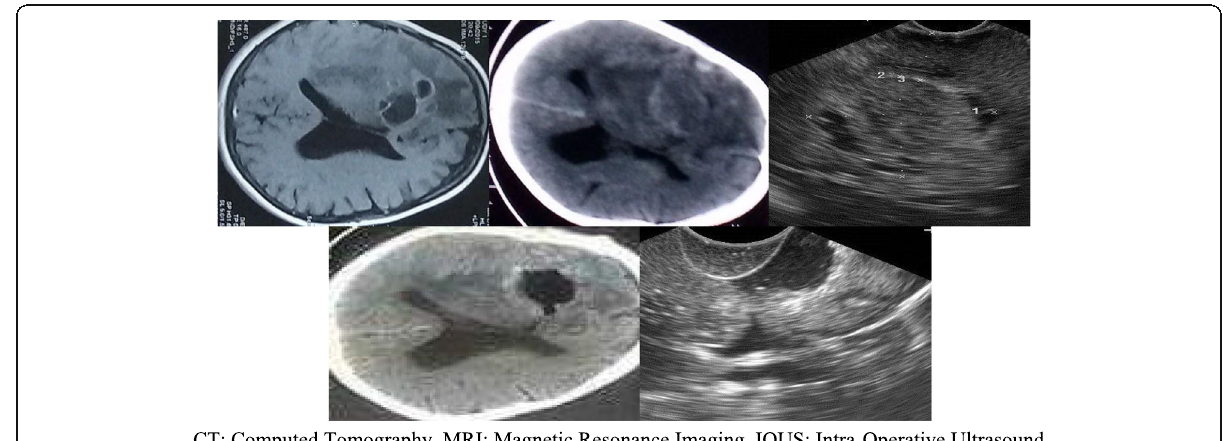
Fig. 8 Gross total resection of glioblastoma; preoperative (MRI T1with contrast, CT with contrast), postoperative CT with contrast and IOUS